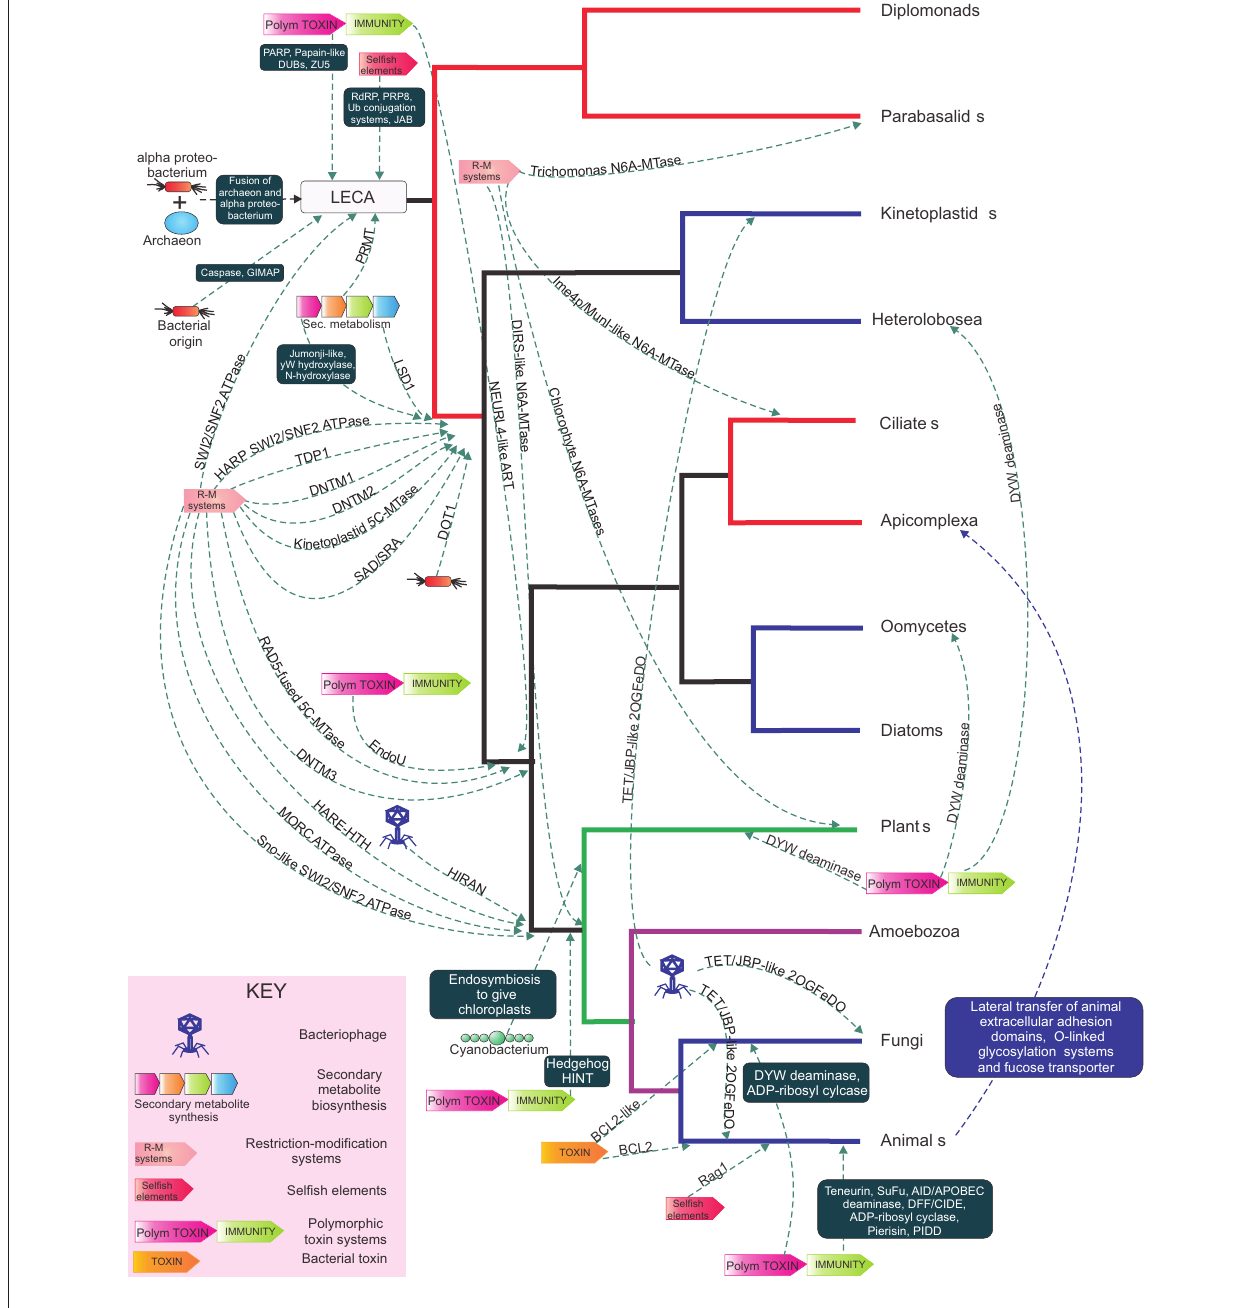
are shown. The transfers are shown as dashed arrows with the arrow head pointing to the ancestor in which the transfer is proposed to have taken place. The dashed lines are labeled either with a single gene or a set of genes enclosed in a box. The conflict systems are shown in the key at the bottom